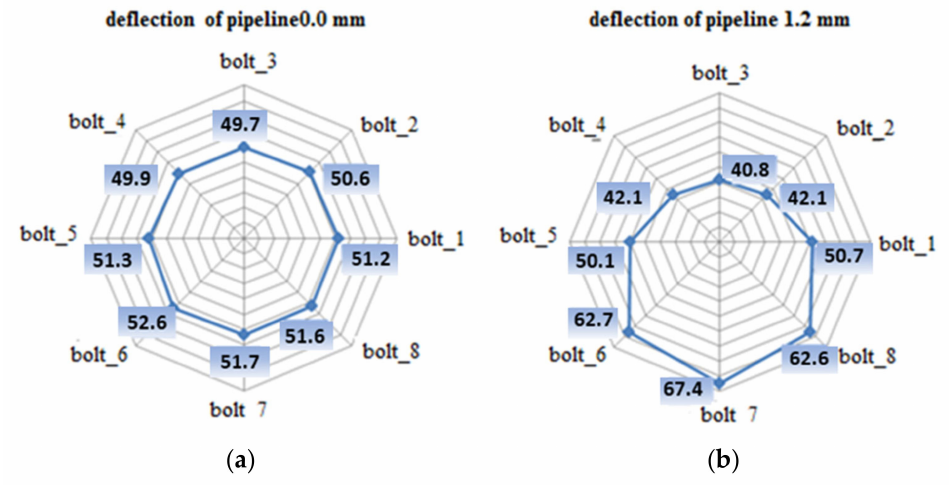
Figure 14. The distribution of the tension force in individual bolts: ( a ) joint before deflection; ( b ) joint deflected by 1.2 mm.